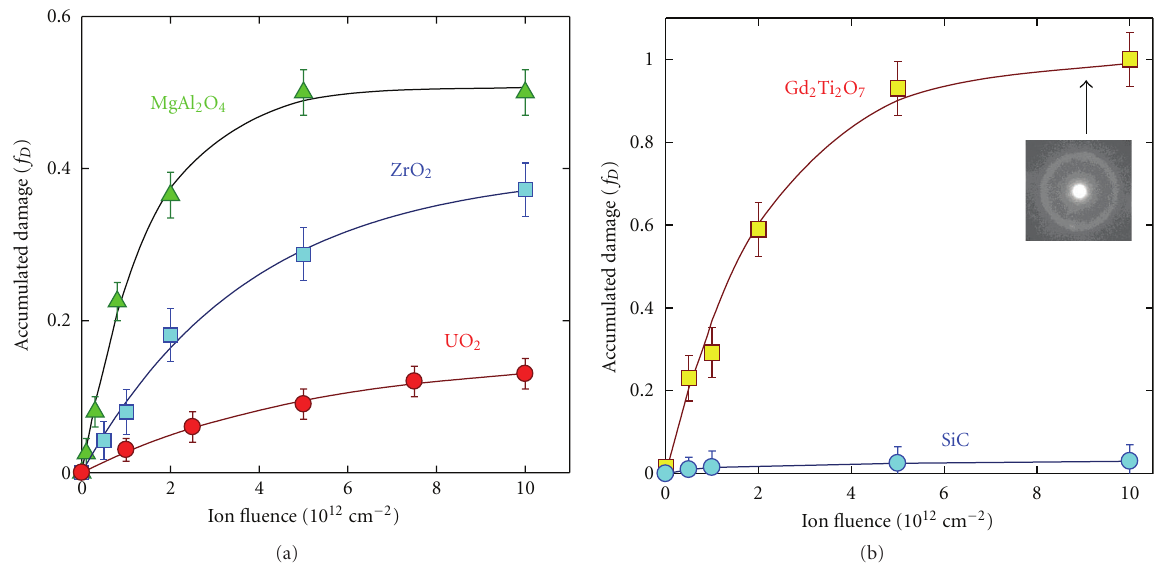
Figure 8: Accumulated damage ( f D ) versus ion fluence for nonamorphizable (a) and amorphizable (b) ceramics irradiated at RT with swift ions. The inset shows a TEM di ff raction pattern recorded at the final fluence on Gd 2 Ti 2 O 7 .